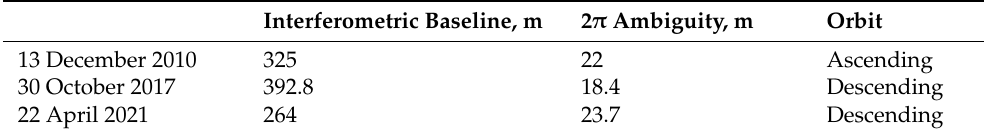
Table 2. TerraSAR-X/TanDEM-X data baseline parameters. Interferometric Baseline,